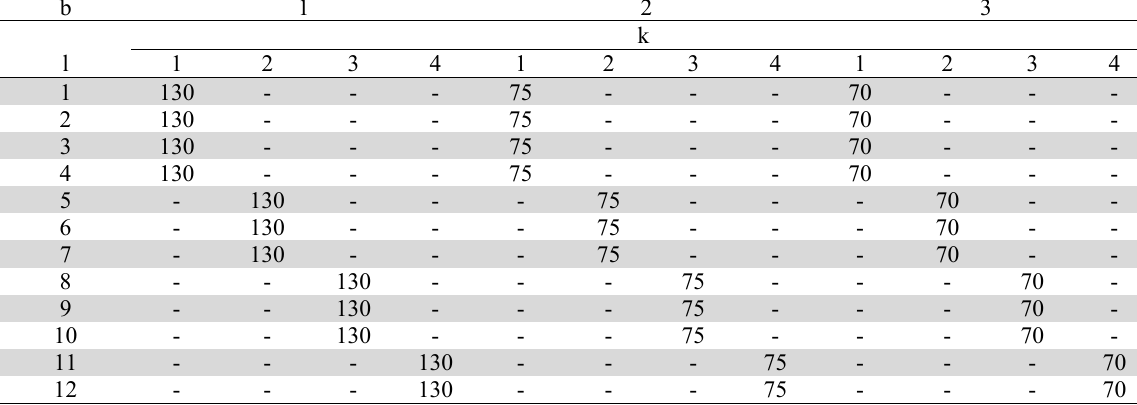
Sales price of final products from distribution centers to retailers(Pr b kl ) (Rial×10 4 )